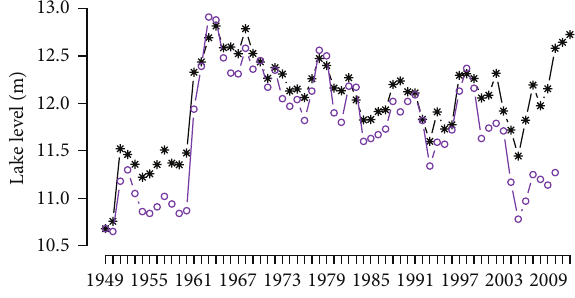
Figure 2: Comparison of Lake Victoria levels modeled using CRU 3.21 (black with asterisks) and observed lake levels (purple with